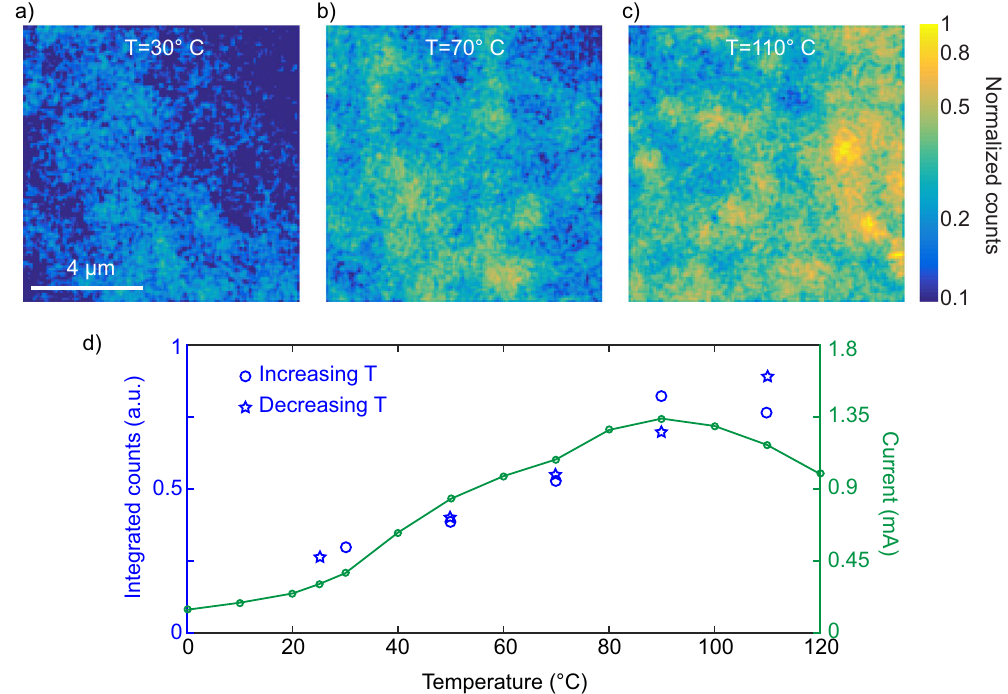
Figure 3. Temperature evolution of the two photon photoluminescence. ( a – c ) TPPL spatial map of P3HT at different temperatures, with a diffraction limited resolution (~400 nm). ( d ) Temperature characteristic of the two-photon photoluminescence for increasing temperature (blue circles) and decreasing temperature (blue stars) and of the supported current (green curve) in the polymer semiconductor transistor. The error bar in the measurement of the TPPL, obtained as the sum in quadrature of the error of each pixel in the spatial images (calculated as √ N, where N is the TPPL signal at each pixel), is always smaller than the size of the symbol